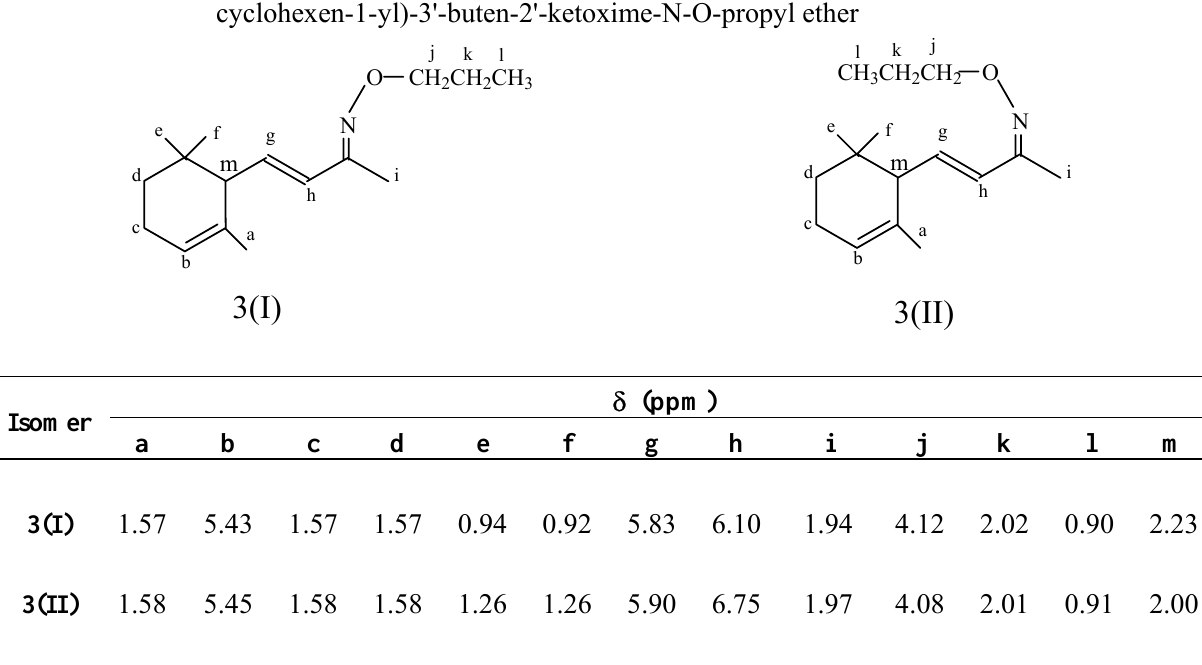
Table 1. 1 H-NMR of spectral data of the E and Z isomers of 4'-(2,6,6-